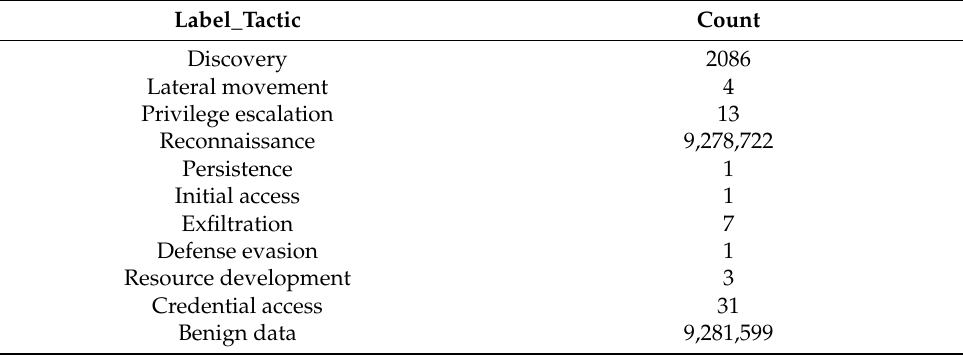
Table 1. Conn log breakdown by MITRE ATT&CK tactic .